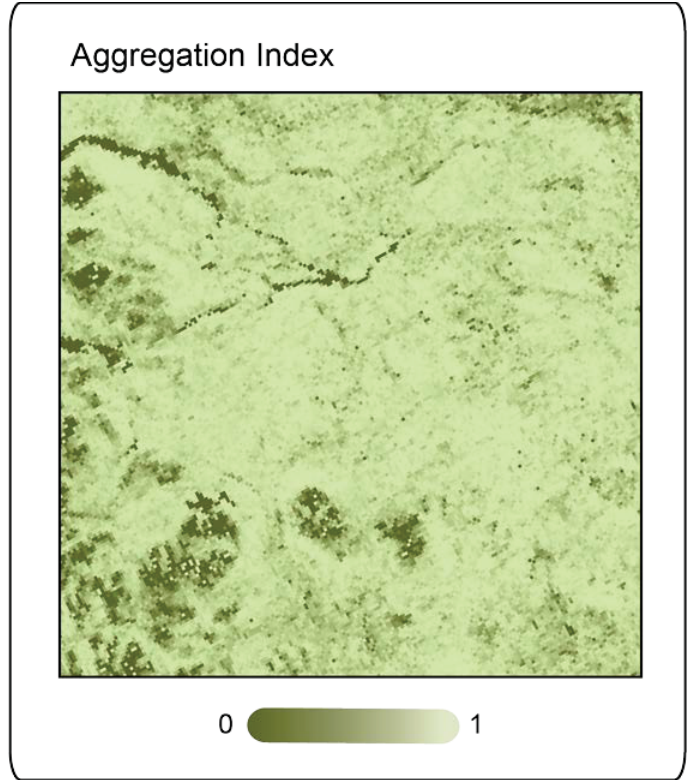
Figure 4. Values for the Aggregation Index in the study site as measured from the 2000 EOSD data